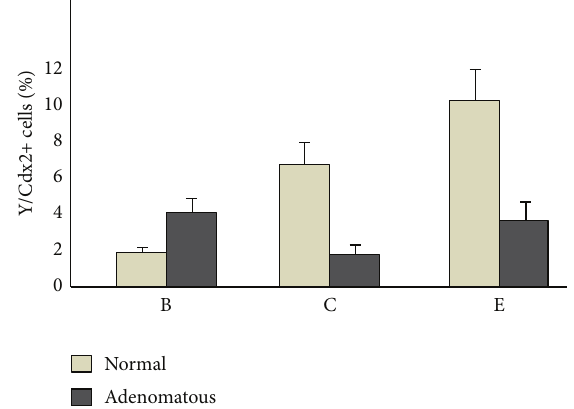
Figure 4: Y-chromosome/CDX-2 positive cells in “normal” and adenomatous tissue in female with Apc mutation transplanted mice. The description of the different groups is reported in Section 2. Data representthemean ± SD.Y-chromosome/CDX-2positivecellsinthe “normal” tissue resulted significantly different among the 3 groups, by ANOVA ( 𝑝 < 0.001 ). B ̸= C ̸= E by Tukey test. Positive cells in the adenomatous tissue resulted significantly different among the 3 groups, by ANOVA ( 𝑝 < 0.01 ). B = E ̸= C by Tukey